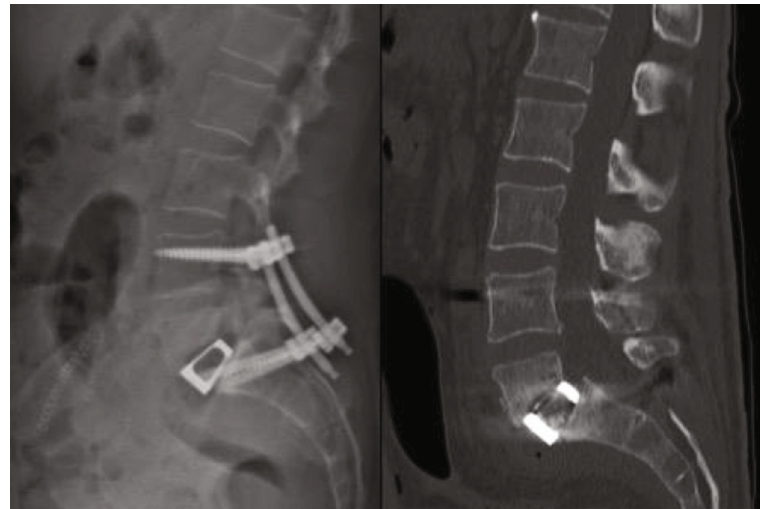
Figure 3: Postoperative (a) lumbar spine radiography in standing position and (b) lumbar CT scan, demonstrating the restoration of the lumbar lordosis and partial reduction of the L5-S1